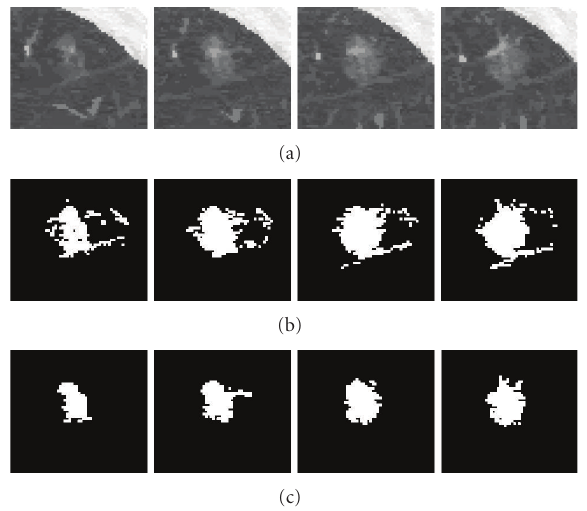
Figure 13: Segmentation of a colonic polyp. In (a), we show a 3D polyp in three contiguous slices, in (b) segmentation results without the shape feature, and in (c) segmentation results based on the proposed method.